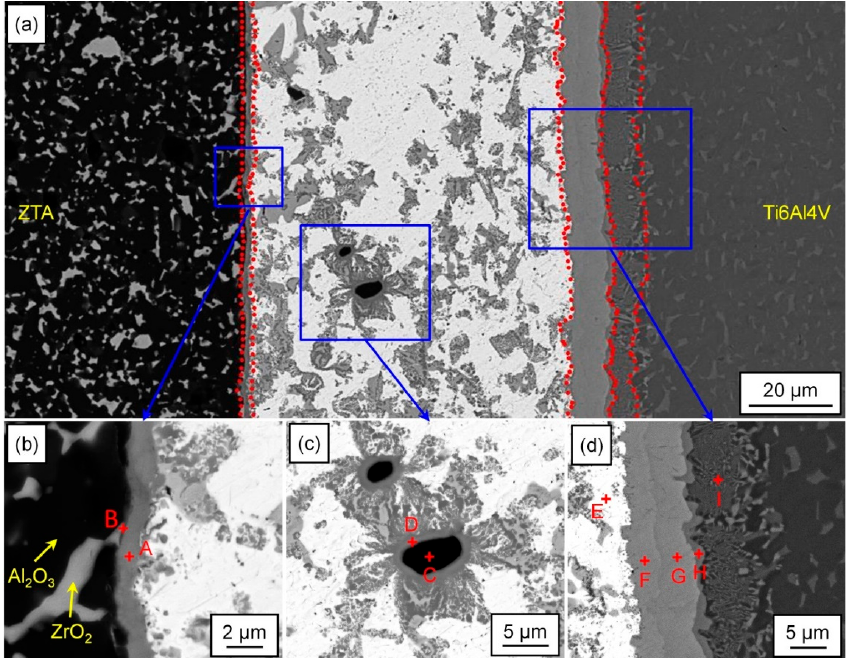
Figure 3. BSE SEM images of the whisker-strengthened ZTA/Ti6Al4V joint brazed at 825 °C for 10 min. ( a ) Low-magnification SEM image. ( b – d ) High-magnification SEM images corresponding to the regions marked in ( a ). Table 1. EDS analysis results of the positions marked in Figure 3 (at.%).